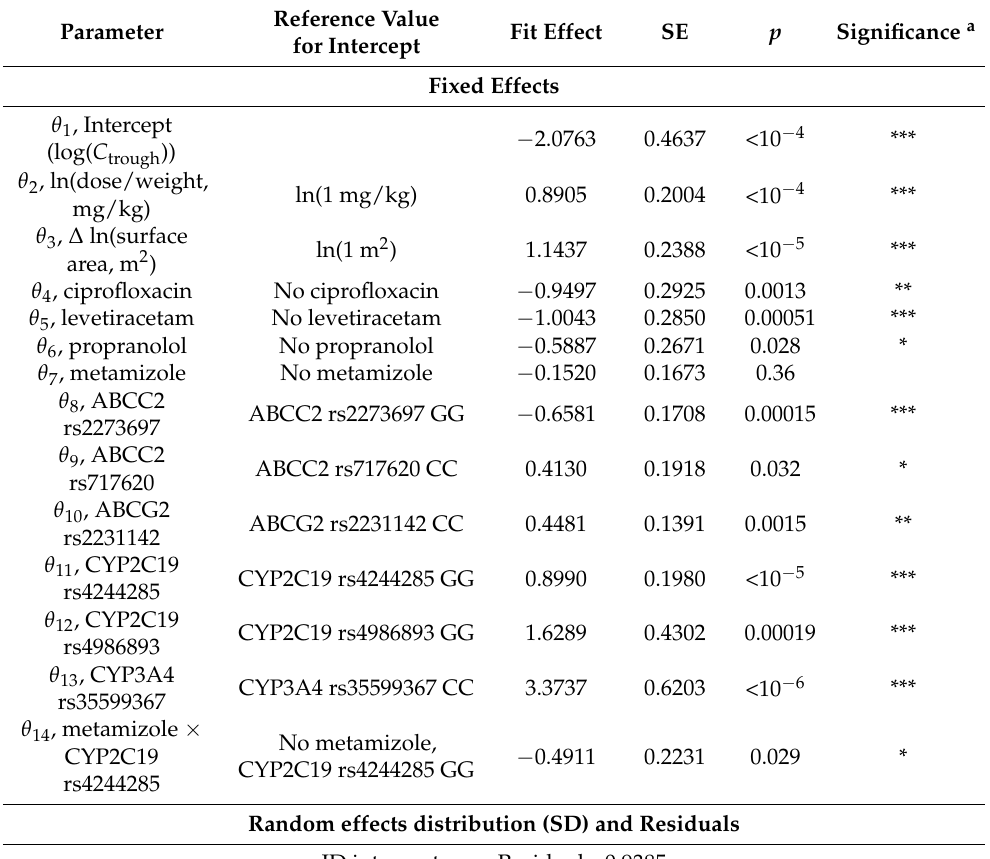
Table 4. Fit parameters with SE and p of the final